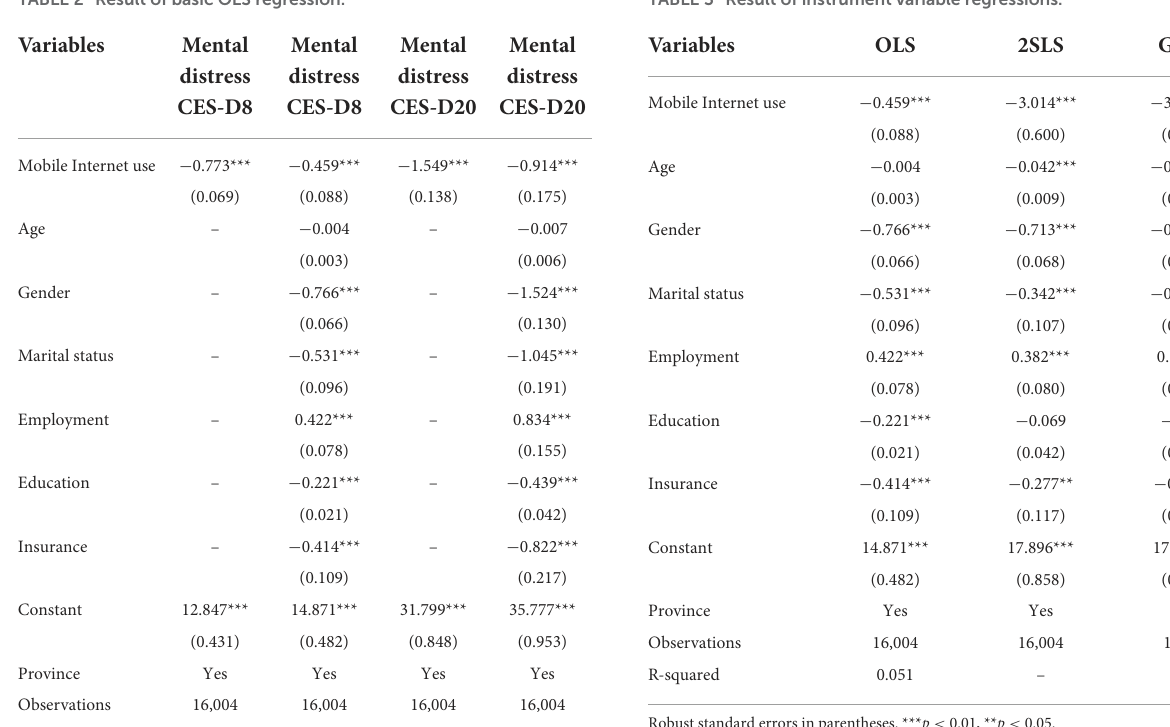
TABLE 2 Result of basic OLS regression. TABLE 3 Result of instrument variable regressions.